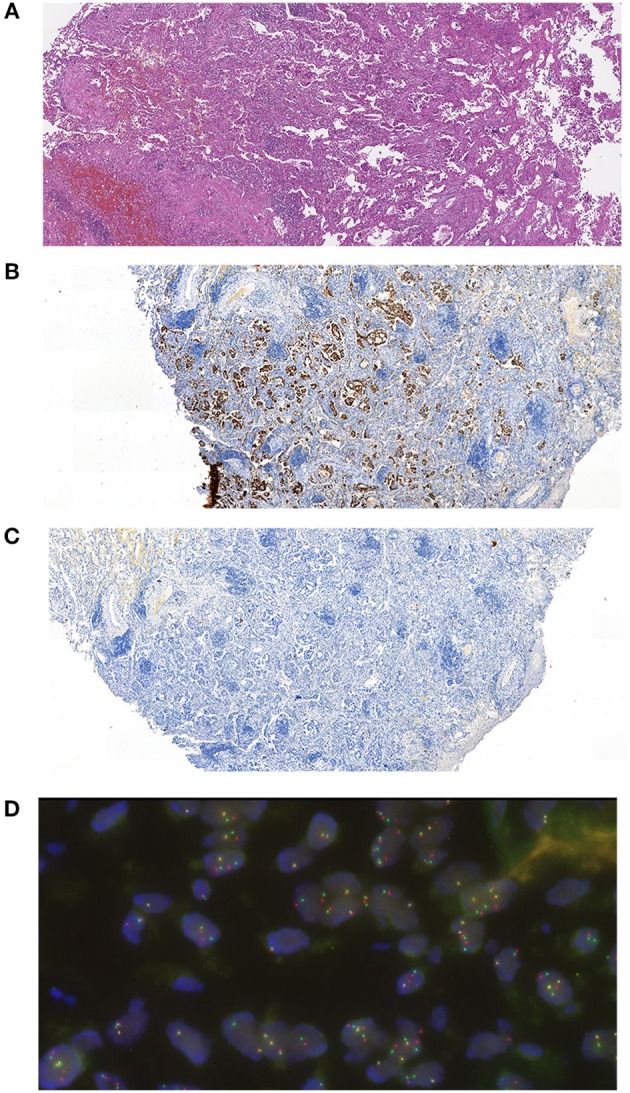
Histological evaluation of the patent's tumor. (A) Hematoxylin and eosin staining microphotograph. (B) Immunohistochemical staining for TTF-1 (SPT24). (C) Immunohistochemical staining for p40 (DeltaNp63). (D) FISH analysis for ALK-EML4 translocation.